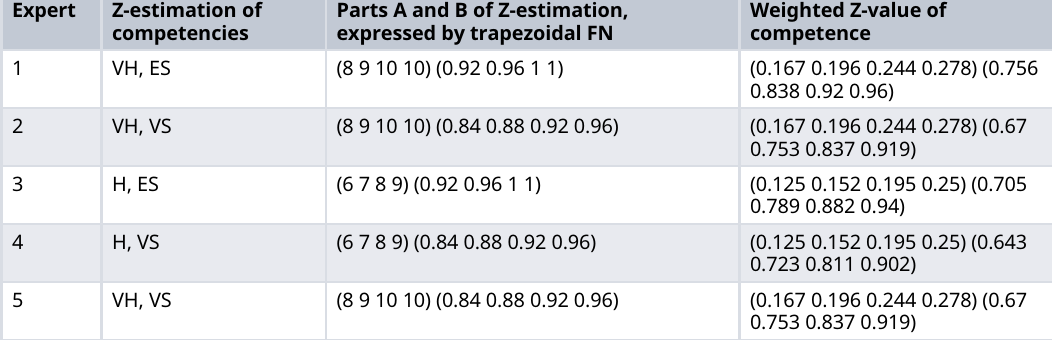
Table 4. Z-number based expert ’ s competence estimates.